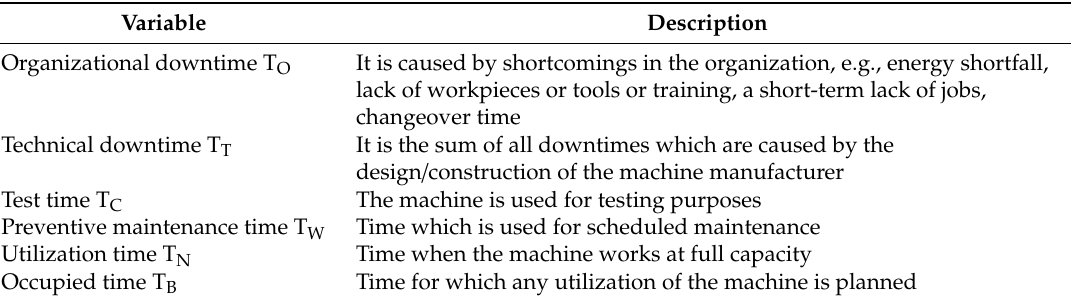
Table 4. Variables for availability calculation according to VDI